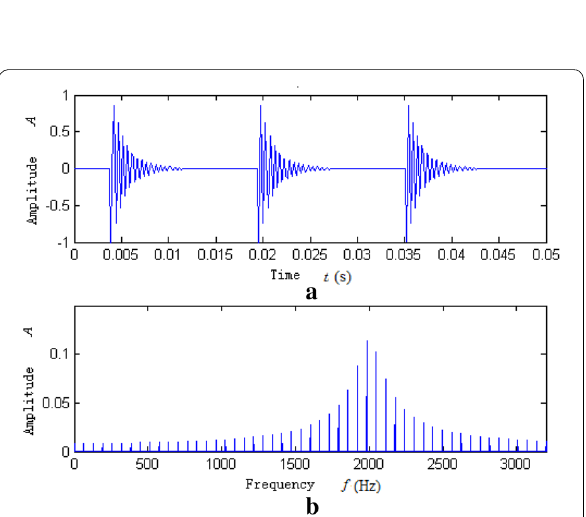
Figure 8 Response 2 (natural frequency: 2000 Hz, phase: 0°): ( a ) time waveform, ( b ) FFT